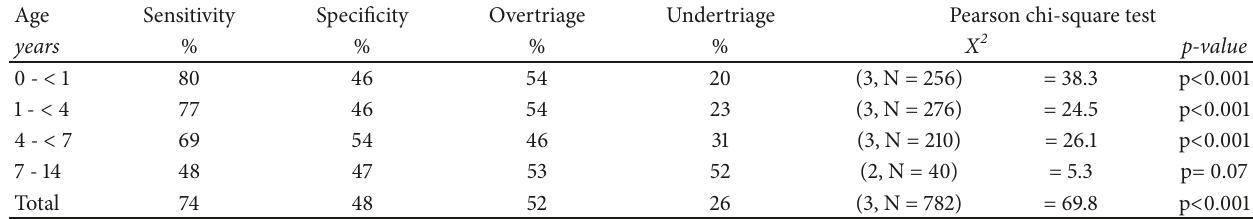
Table 3: Sensitivity, specificity, over- and, undertriage by age groups.